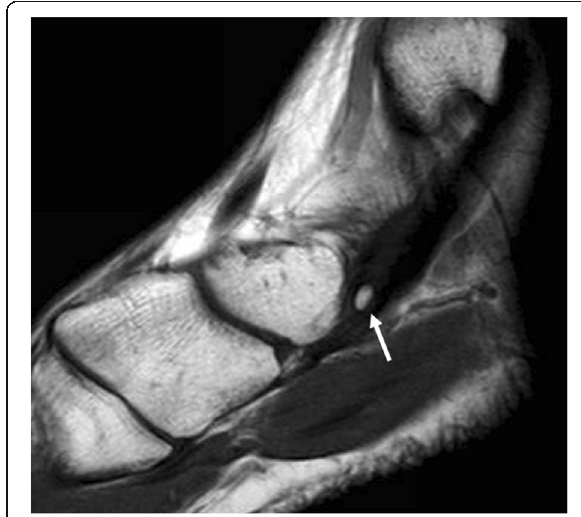
Fig. 2 Type I accessory navicular. Sagittal fast spin echo T1 (FSE T1) demonstrates the incidental finding of a type I accessory navicular in a 33-year-old man, referred with the suspicion of arthropathy. Signal intensity is normal. Note how this is embedded in the tibialis posterior tendon (white arrow)